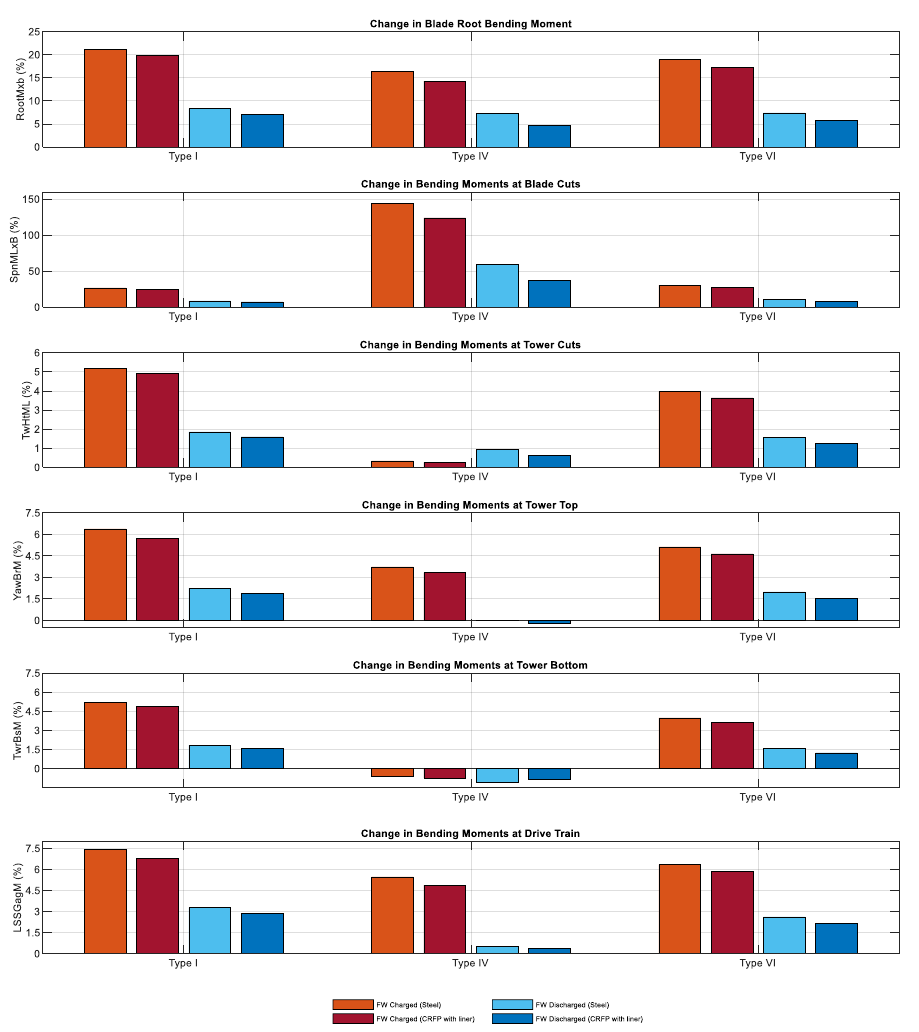
Figure 12. Comparison of changes in fatigue loads in (from top to bottom) blade root bending moment, bending moments at blade cuts, bending moments at tower top, bending moments at tower bottom, and bending moments at drive train, between steel accumulator and CFRP with metal liner accumulator for FW types I, IV, and VI in charged (red) and discharged (blue) status, both with respect to the ultimate loads of the original WT without FW system.